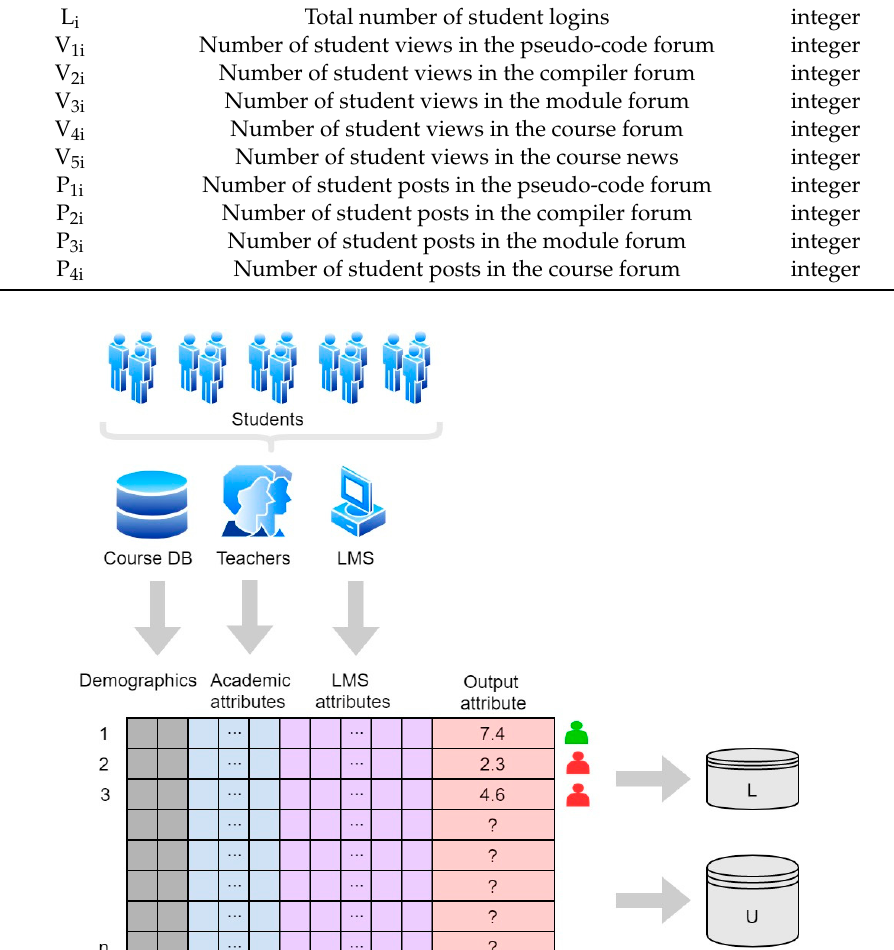
Figure 2. Gathering the data during the academic year.